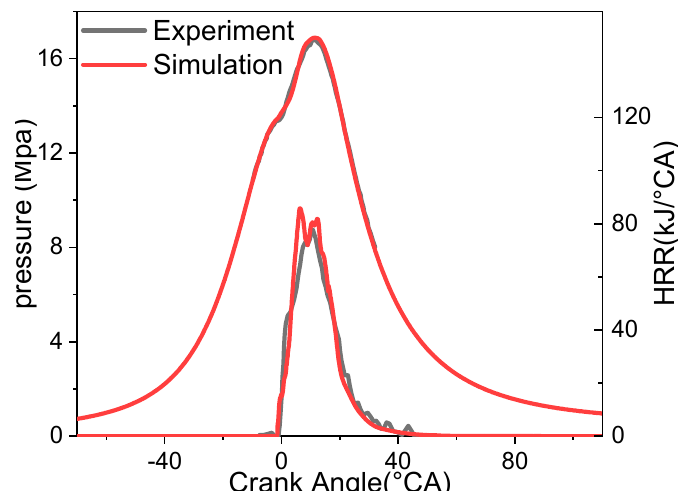
Figure 2. Comparisons between the calculated and measured in-cylinder pressure and HRR traces. Table 3. Comparison between the calculated and measured parameters. Experiment